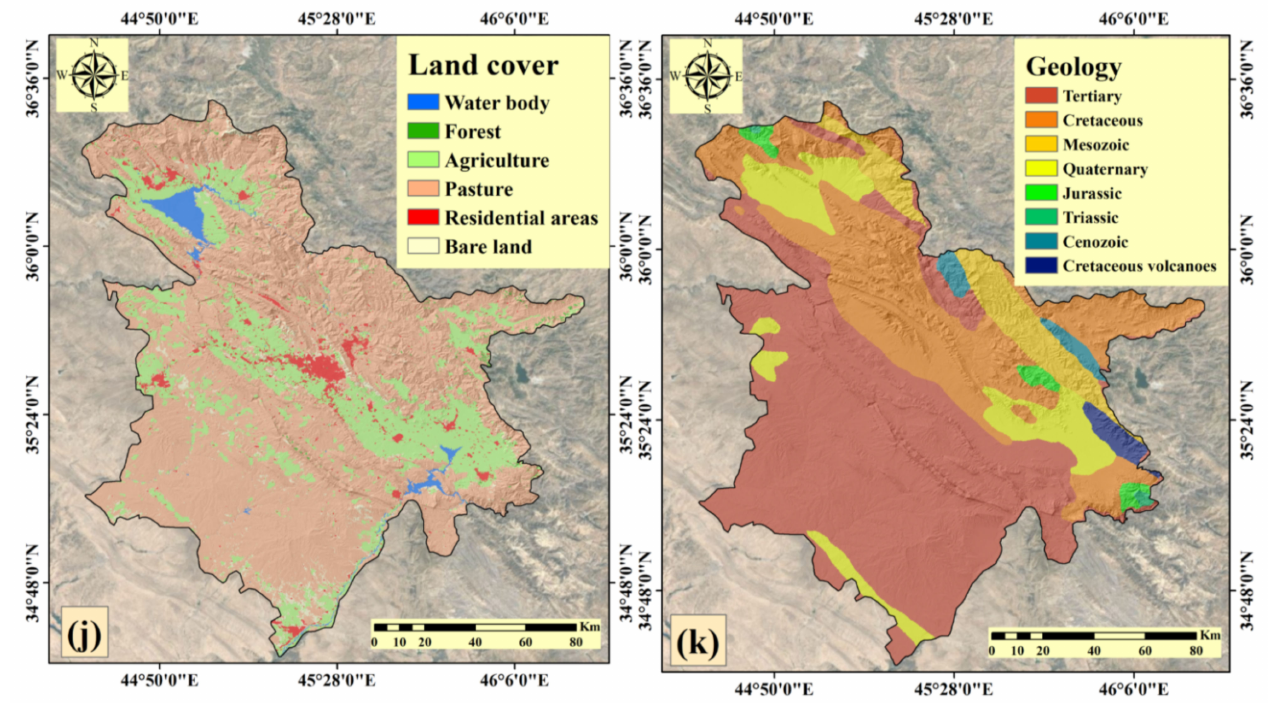
Figure 4. Influential flood factors: ( a ) altitude, ( b ) slope, ( c ) slope aspect, ( d ) TWI, ( e ) SPI, ( f ) plan curvature, ( g ) rainfall, ( h ) NDVI, ( i ) distance to river, ( j ) land cover, and ( k )